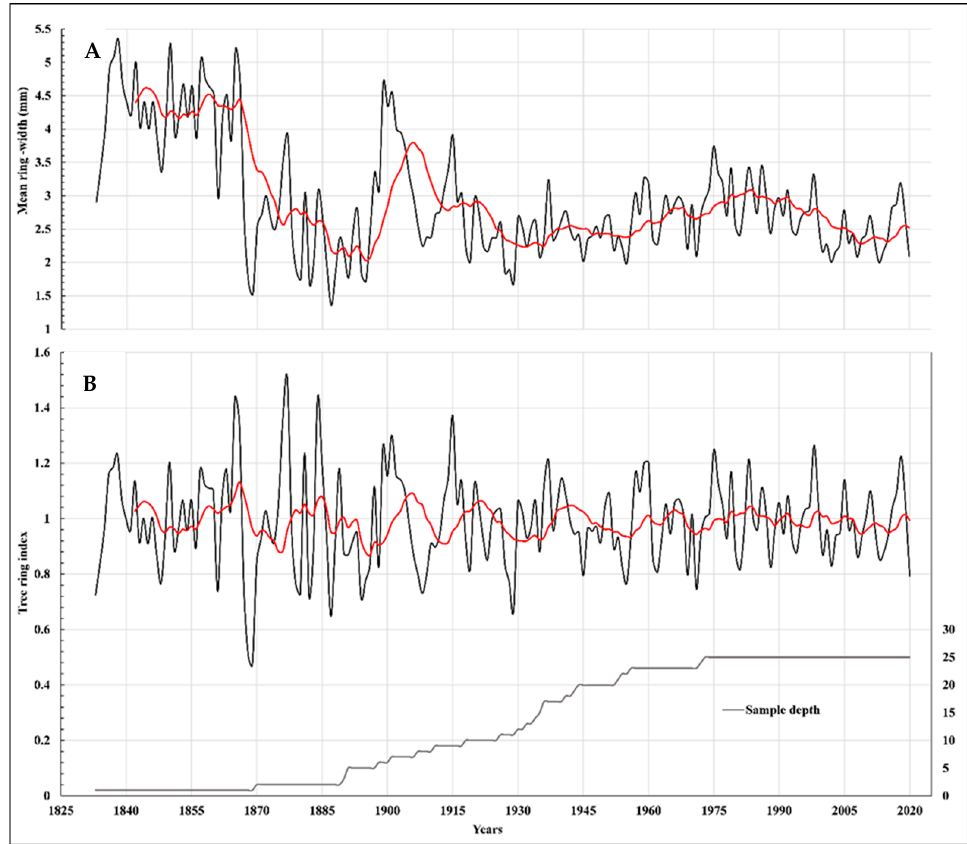
Figure 2. A. borisii-regis tree-ring chronology in Pertouli University Forest. Plot ( A ) shows non- standardized annual tree-ring width. Plot ( B ) shows the standardized annual tree-ring index. The red line superimposed on both tree-ring plots indicates the mean moving average of 10 years.